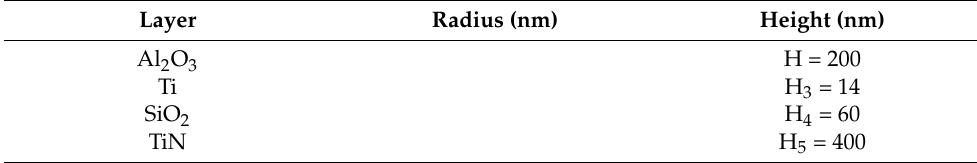
Table 1. Initial structural (except for nanopillars) parameters used in the simulation.